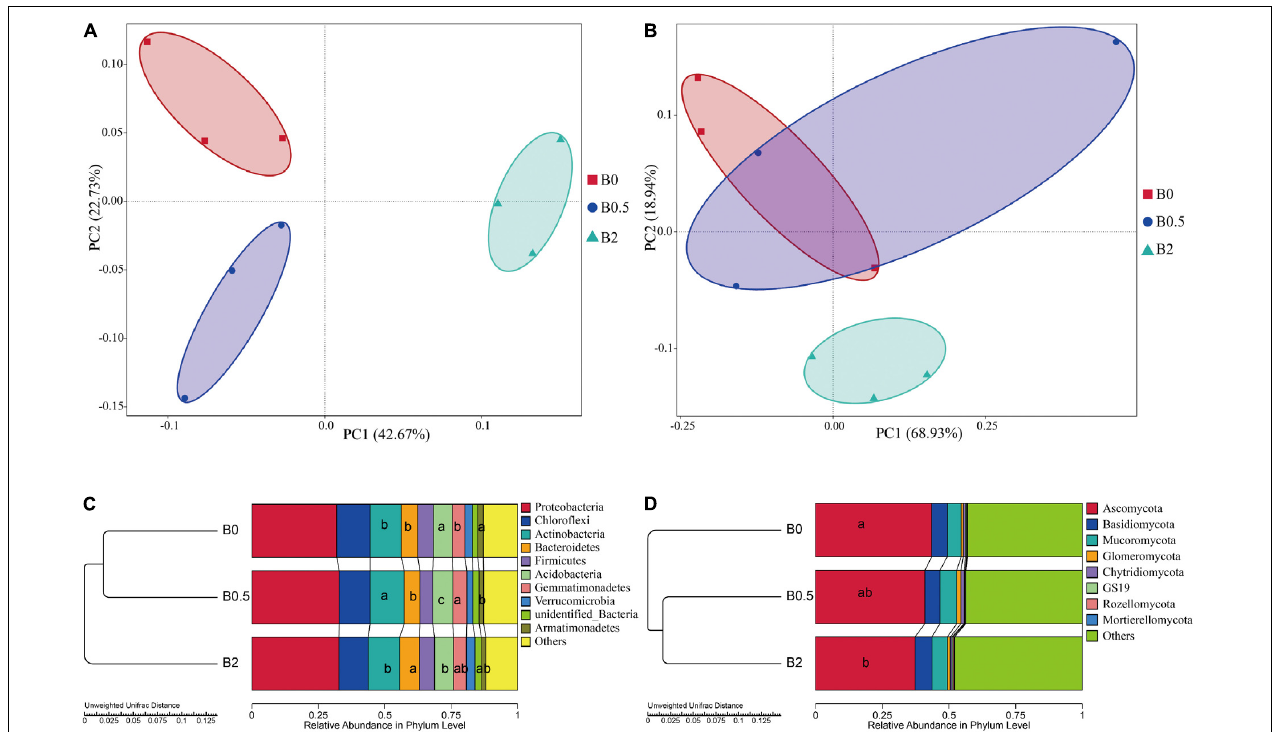
FIGURE 4 | Principal coordinate analysis (PCoA), hierarchical clustering and the relative abundances of bacteria and fungi. Panel (A,B) are the PCoAs of the bacterial and fungal communities at operational taxonomic unit level, respectively; (C,D) are the unweighted hierarchical clustering and relative abundances of bacteria and fungi at phylum levels, respectively. Different letters in columns show significant differences as determined by the Duncan’s multiple range test ( P < 0.05; n = 3).